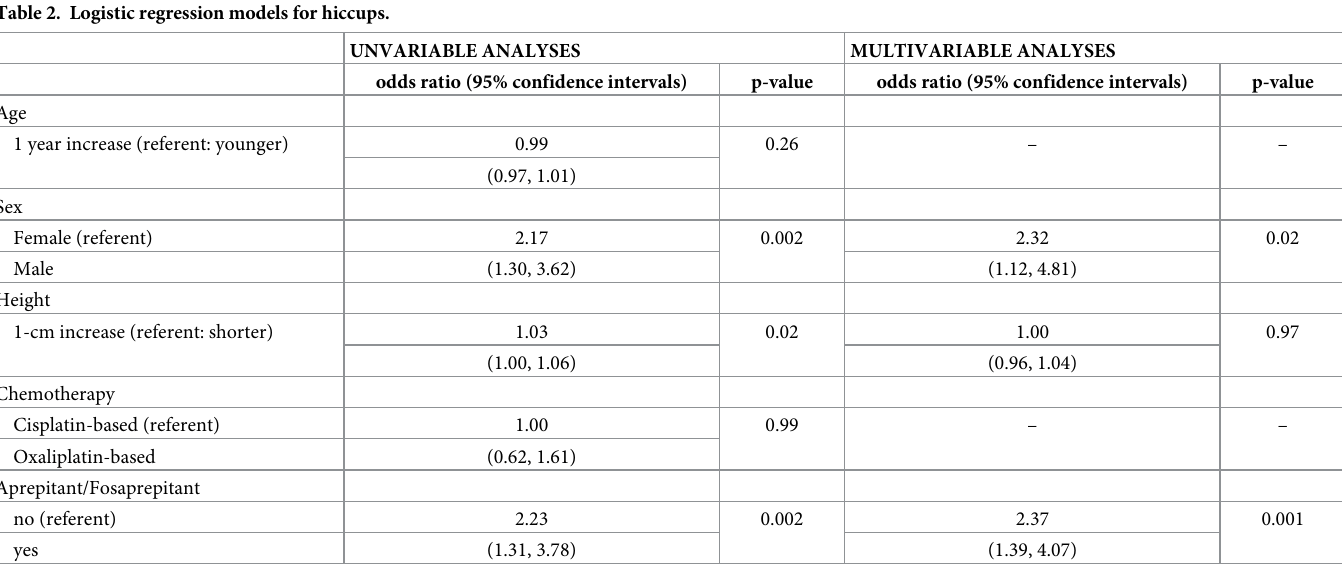
Table 2. Logistic regression models for